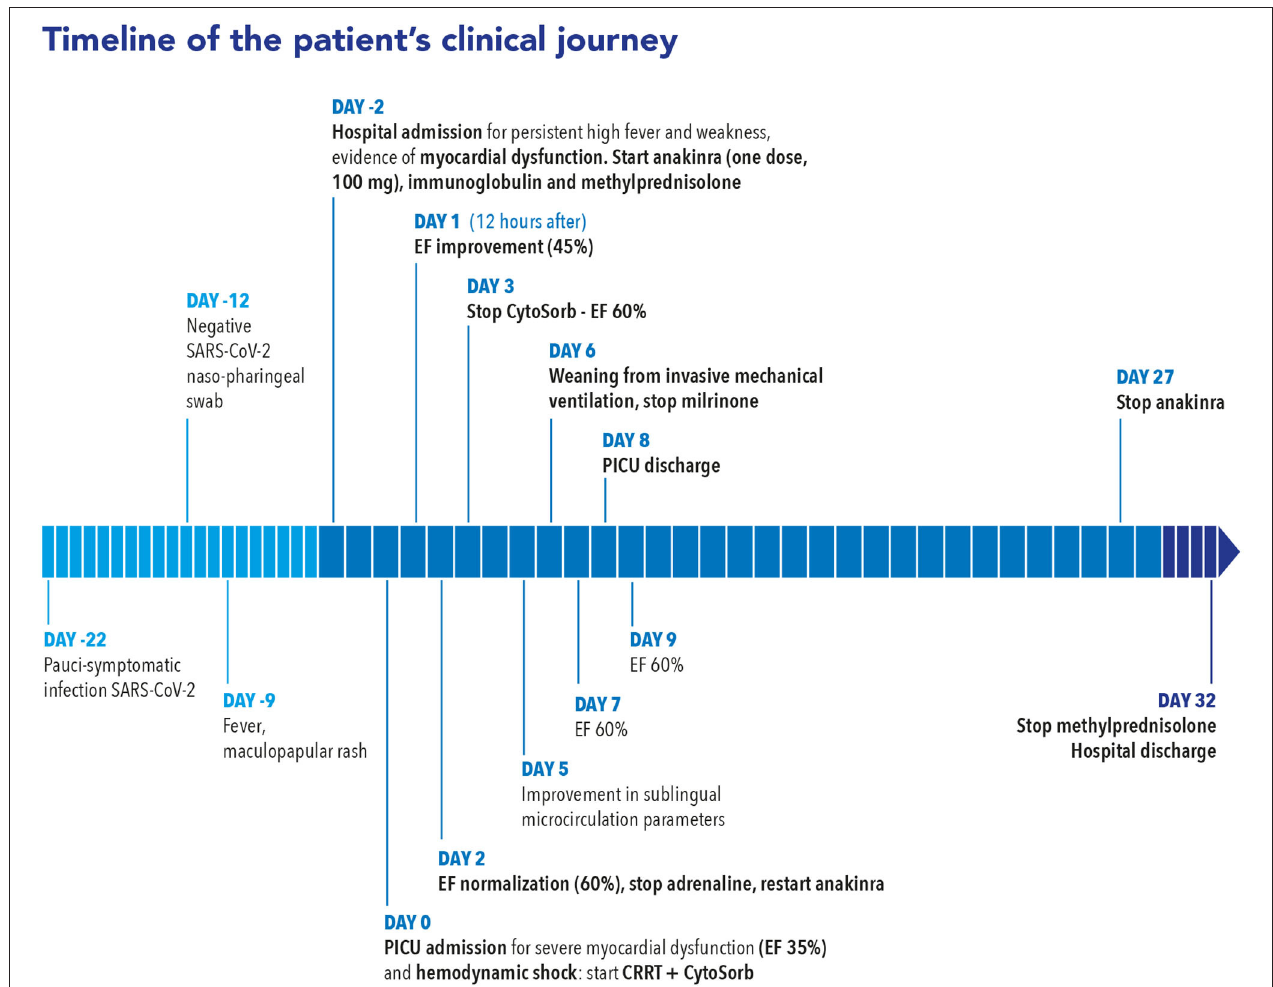
FIGURE 4 | Clinical timeline of a 14-year-old girl diagnosed with SARS-CoV-2-related multisystem inflammatory syndrome with severe myocardial dysfunction and refractory shock. The timeline shows the time course of the clinical evolution and the timing of the multimodal therapeutic approach based on immunomodulatory drugs and extracorporeal blood purification with continuous renal replacement therapy (CRRT) plus CytoSorb